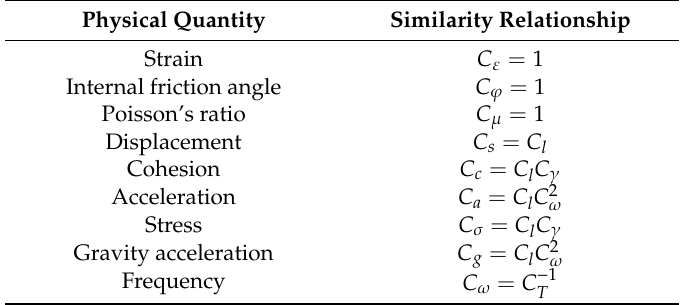
Table 2. Similarity criteria of physical quantities.